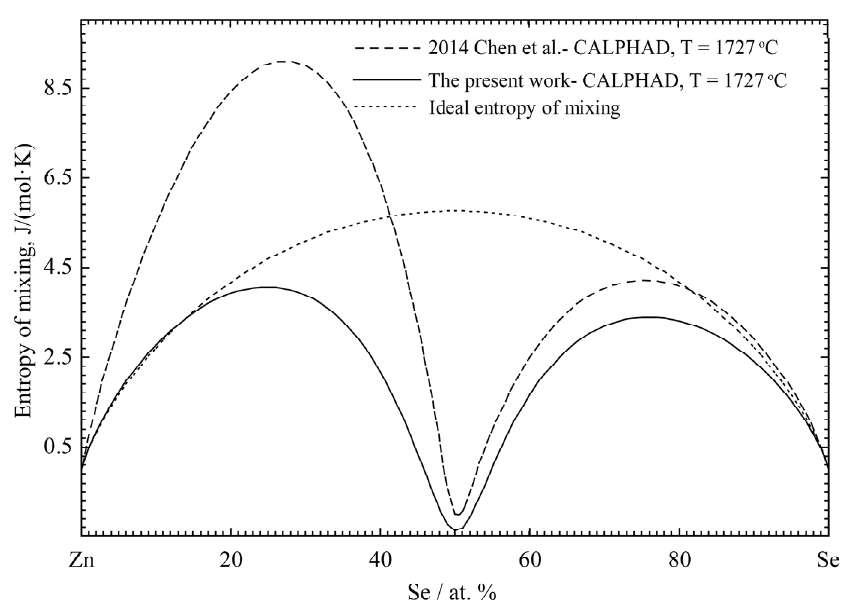
Figure 19. The calculated entropy of mixing at 1727 °C in the Zn-Se system compared with previously optimized results by Chen et al. [125].